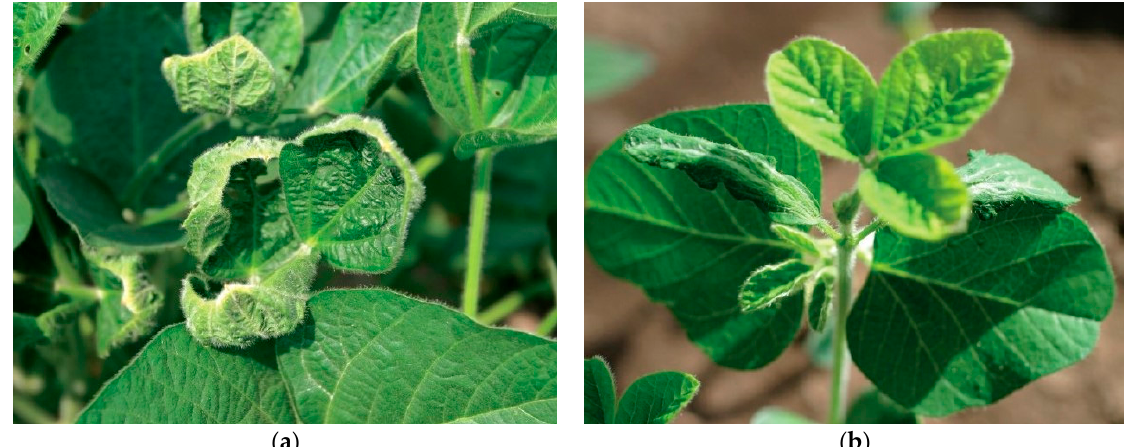
Figure 1. ( a ) Represents distinct leaf cupping symptoms consistent with sublethal dicamba exposure in soybean plants. ( b ). Represents injury consistent with leaf strapping symptomology following 2,4-D injury in soybean plants.